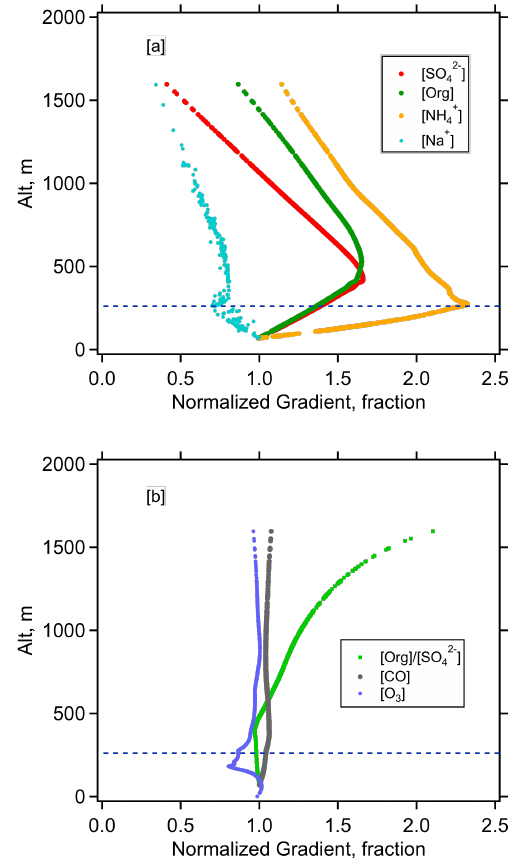
Figure 13. Normalized vertical distribution profiles of (a) BC aerosol SO 2 − , NH + , Org, and Na + ; (b) BC O 3 and CO as well 4 4 the [Org]/[SO 2 − ] 4